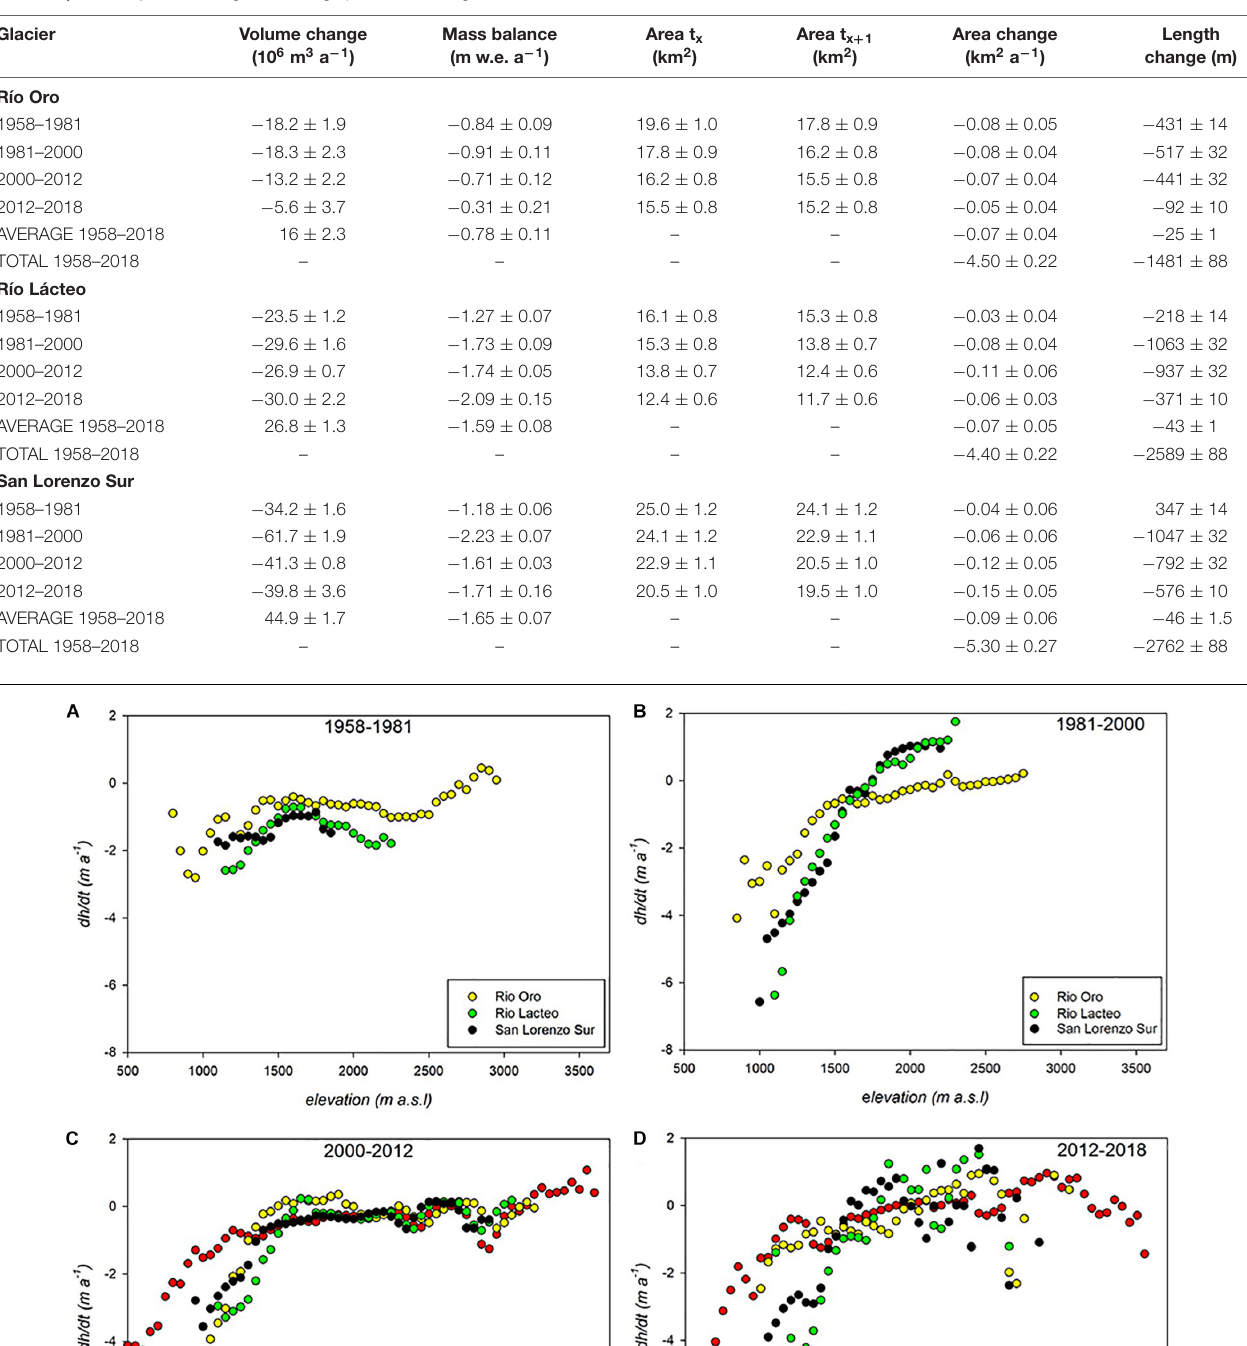
TABLE 2 | Summary of derived glacier change parameters for given time intervals. Glacier Volume change